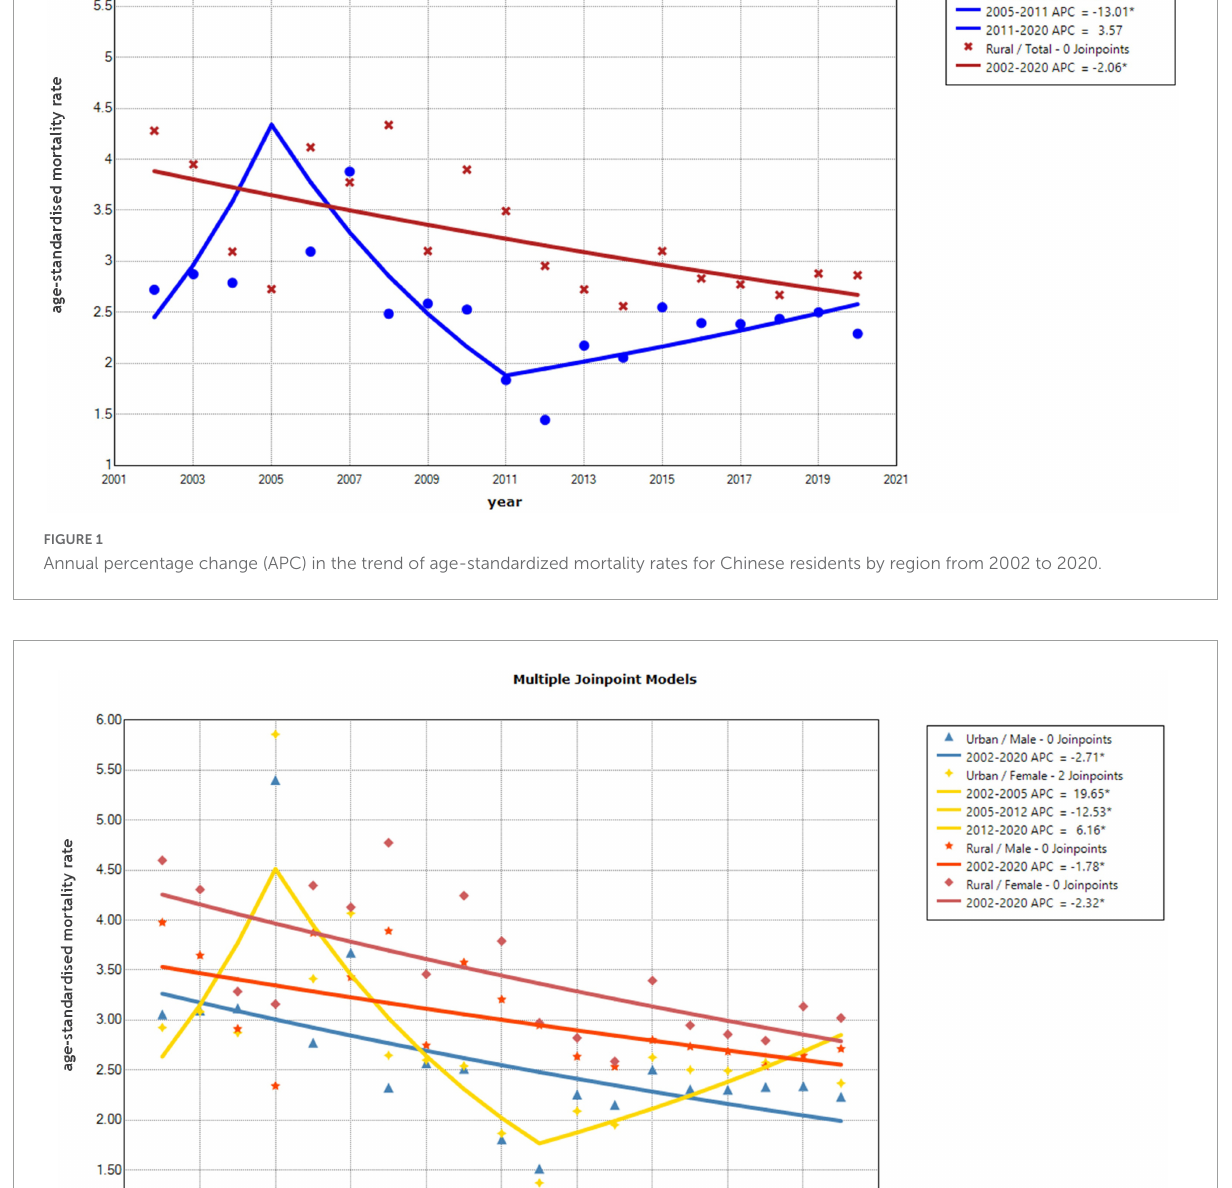
residents. Its good fit is characterized by deviations of 68.15, scaling deviations of 68.15, and Pearson coefficients of 82.37, with 1,439 degrees of freedom in the model ( P > 0.05). In terms of mortality, both age and year were independent risk factors.